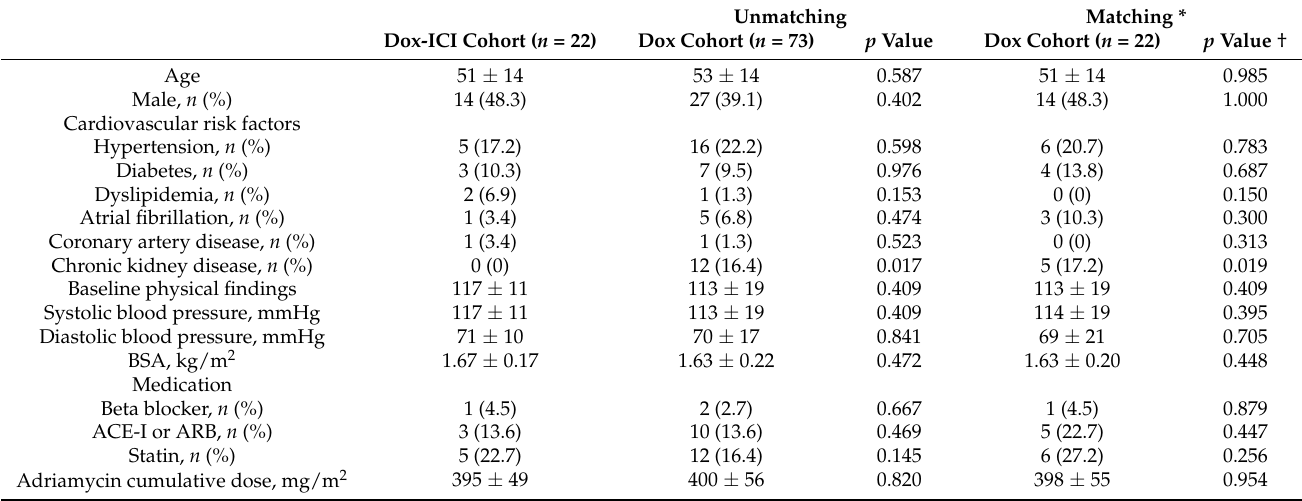
Table 1. Baseline characteristics of the study population.